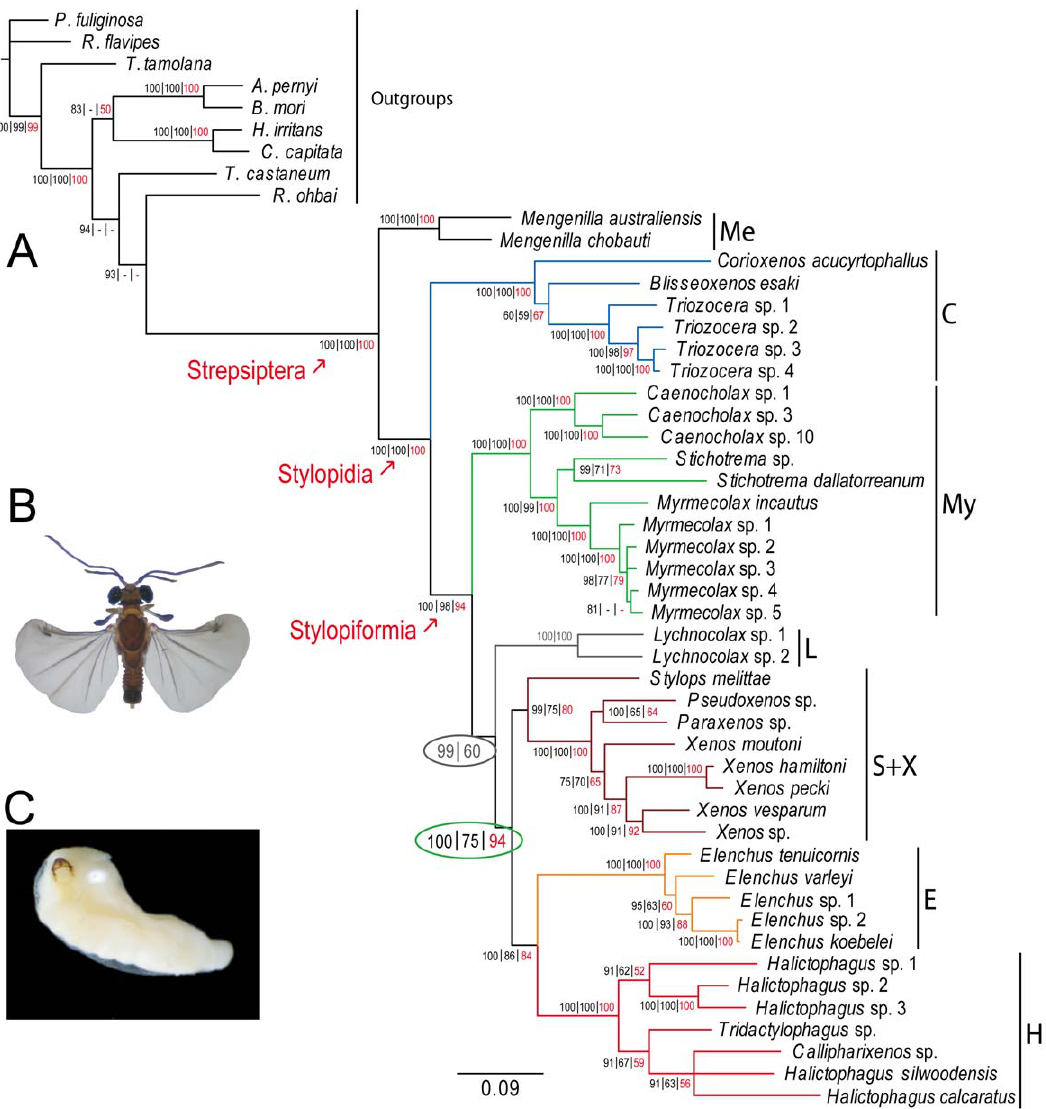
Figure 1. Molecular phylogeny of Strepsiptera. ( A ) Branch lengths from the BI 50% majority rule tree, with support values from BI and ML analyses appearing next to nodes. Support values (%)=BI posterior support | 1000 ML parametric bootstraps with Lychnocolax | 500 ML parametric bootstraps without Lychnocolax. Grey oval: support values=BI posterior support | 1000 ML parametric bootstraps including Lychnocolax . Green oval: increased ML support following removal of Lychnocolax . Me=Mengenillidae; C=Corioxenidae; My=Myrmecolacidae; L= Lychnocolax ; S + X=Stylo- pidae + Xenidae; E=Elenchidae; H=Halictophagidae. ( B ) Male Caenocholax fenyesi sensu lato ( C ) Female Caenocholax fenyesi sensu lato [4].